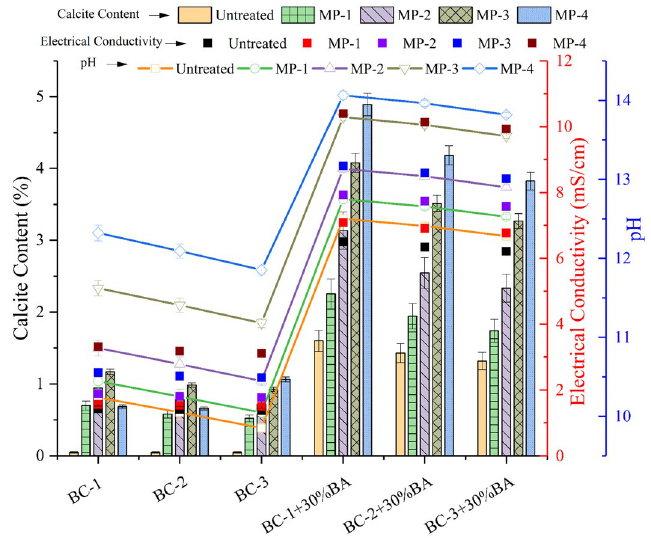
Figure 4. Effect of biostimulated MICP treatment on chemical properties of the expansive soil.